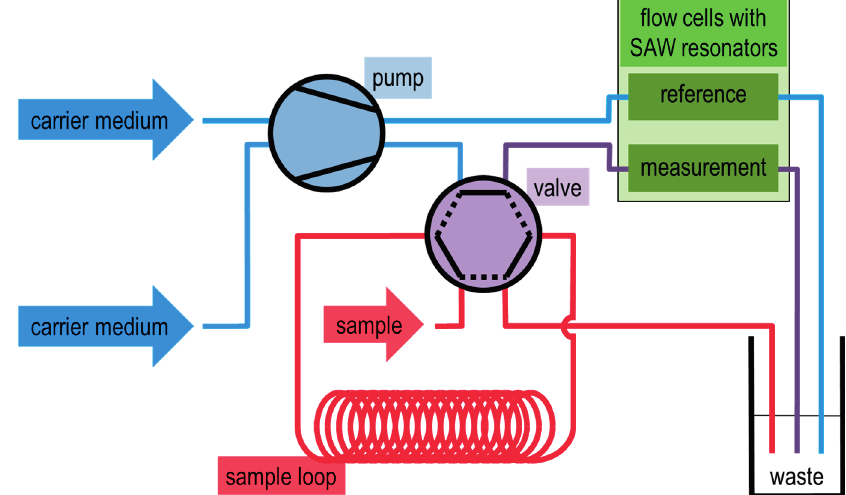
Figure 4. Flow injection analysis system for the SAW resonator measurement setup. Carrier medium was driven by a pump through the reference flow cell or through a valve connected with the measurement flow cell. The solid lines in the valve represent the load mode, in which the sample loop is loaded while the measurement cell is rinsed with carrier medium. The dotted lines represent the inject mode in which the carrier medium moves the sample through the measurement